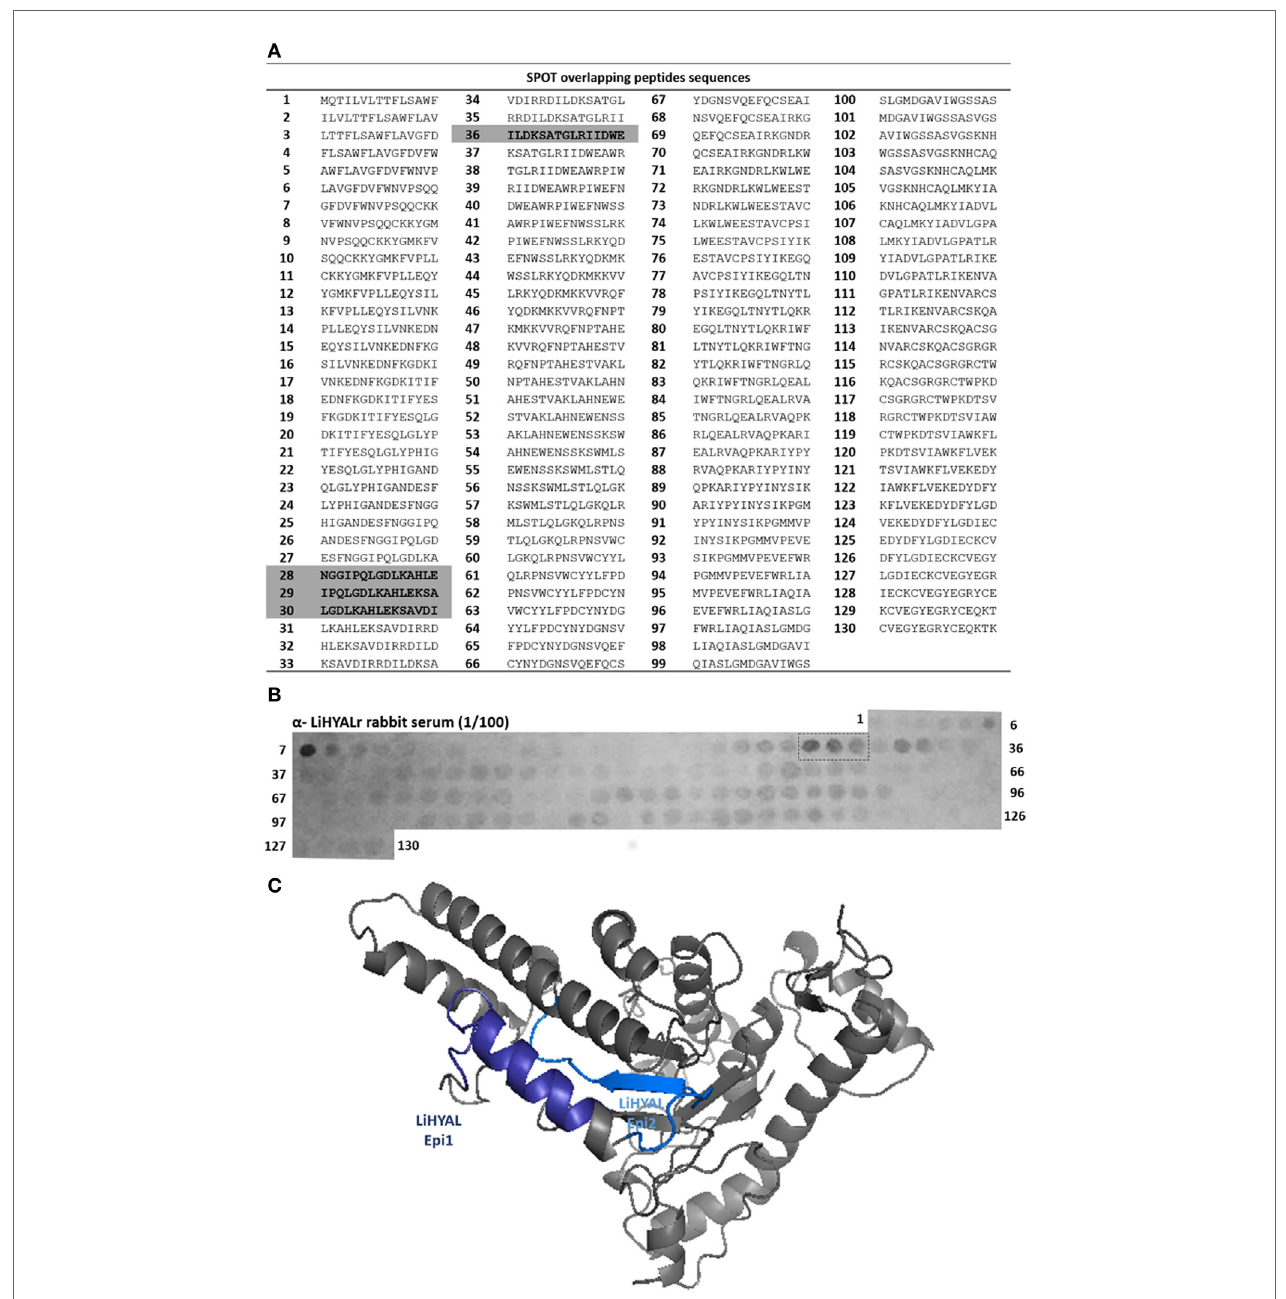
FigUre 2 | Epitope mapping of LiHYAL by SPOT method. (a) List of peptides sequences derived from LiHYAL sequence synthetized bound to the membrane, according to spot number. Sequences of most reactive spots and the chosen peptides containing the active site are highlighted in gray. (B) Cellulose membrane containing bound 15-mer overlapping peptides derived from LiHYAL sequence, probed with anti-rLiHYAL rabbit serum, diluted 1/100. After incubation with secondary anti-rabbit-alkaline phosphatase antibody, MTT-BCIP substrate was added, revealing reactive spots. Spots of higher intensity (measured by ImageJ software) are marked by a dotted line. (c) Homology model of LiHYAL, generated by the I-TASSER server (34), using hyaluronidase (HYAL) 1, from Homo sapiens (PDB: 2PE4) as template. The epitope sequence mapped in the membrane are marked in dark blue and active site in light blue, in the modeled